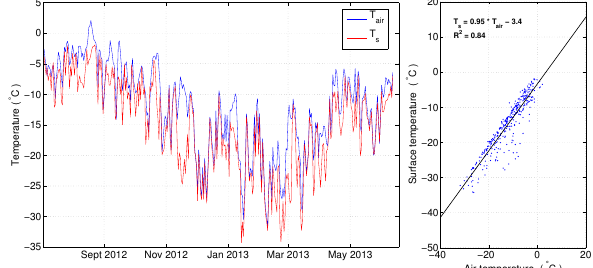
Fig. 7. Comparison between daily measured air ( T air ) and surface ( T s ) temperature between 3 July 2012 and 13 June 2013 at Col du Dôme.